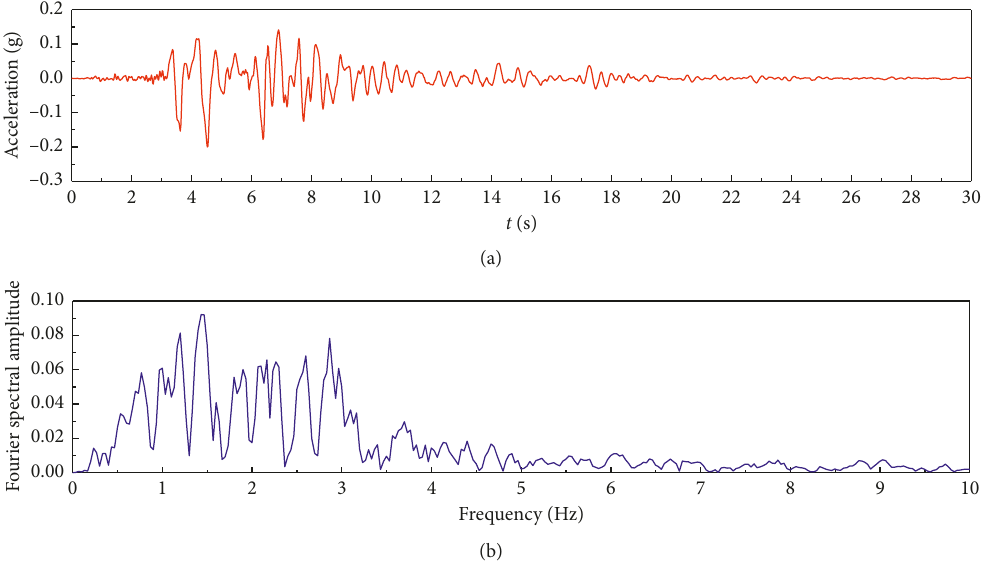
Figure 7: Ground motion acceleration input: (a) ground motion time history; (b) Fourier